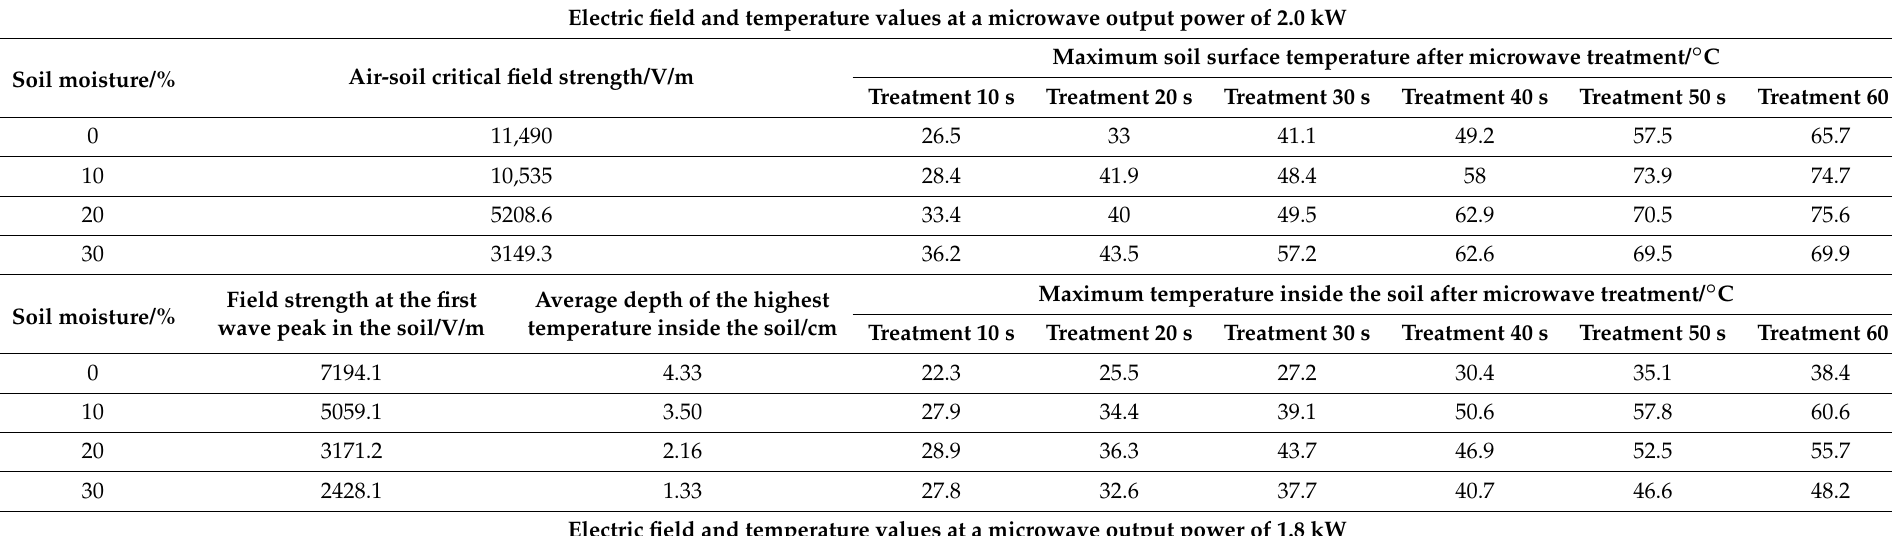
Table 7. Electric field and temperature values at a microwave output power of 2.0 kW,1.8 kW and 1.6 kW. Electric field and temperature values at a microwave output power of 2.0